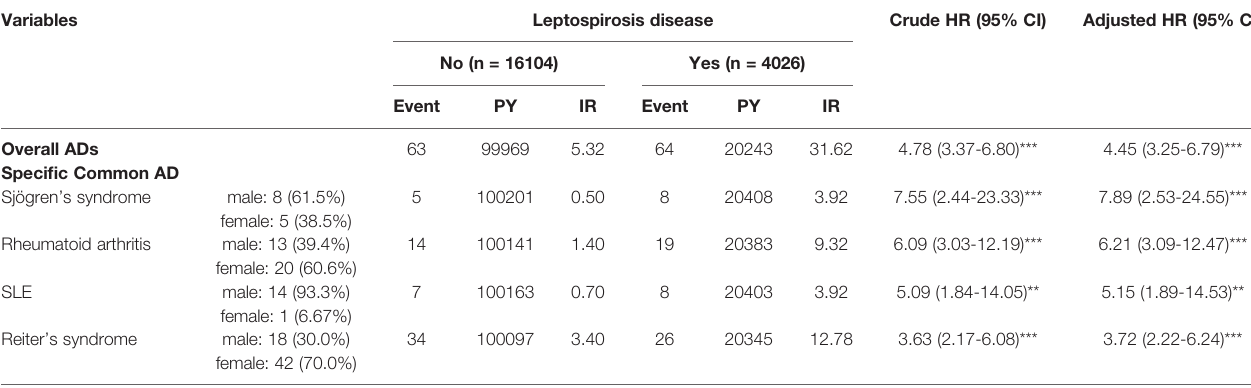
TABLE 4 | Incidence and HRs of each AD between patients with and without leptospirosis.